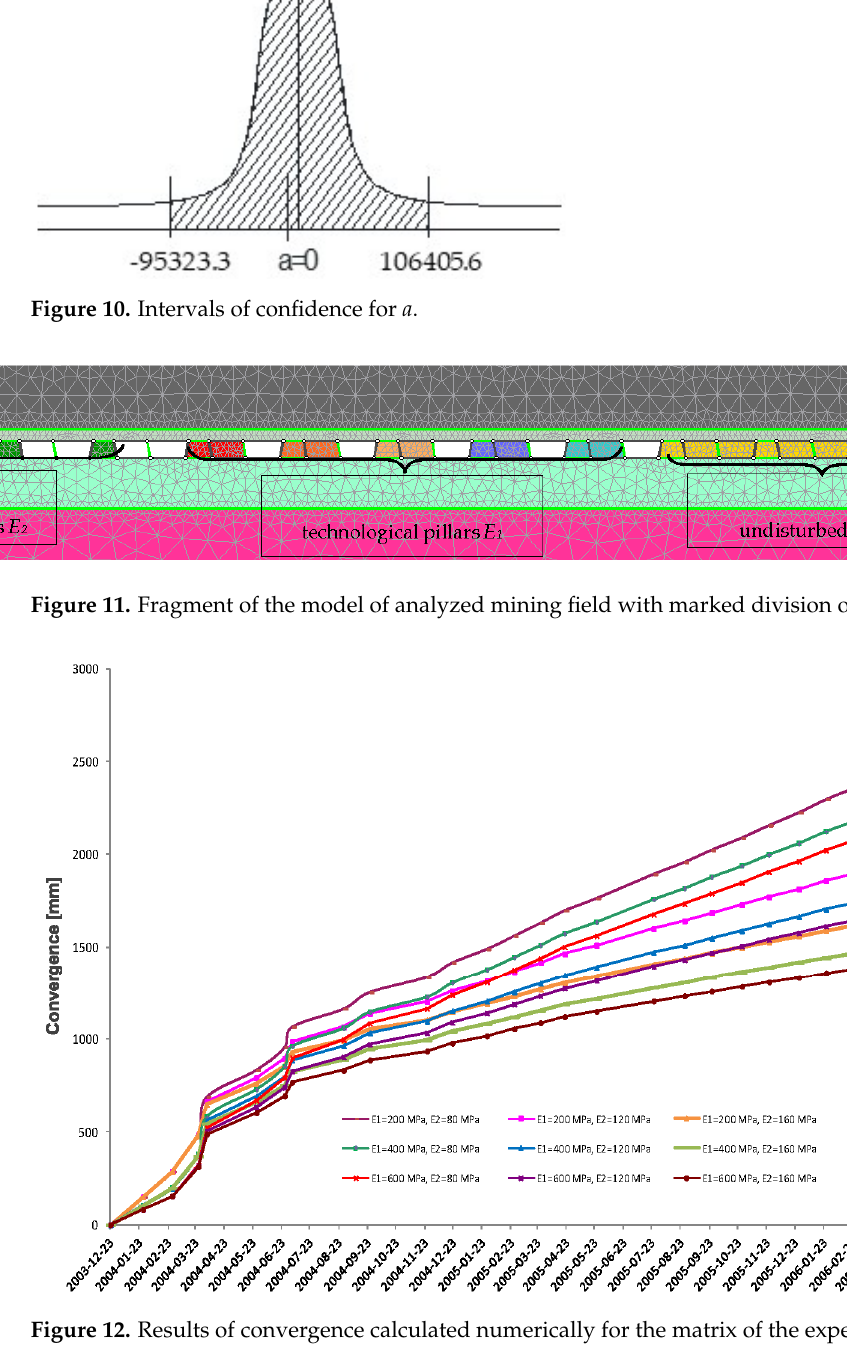
Table 4. Pillar parameters set for the elastic model using the Statistica v. 10 program.